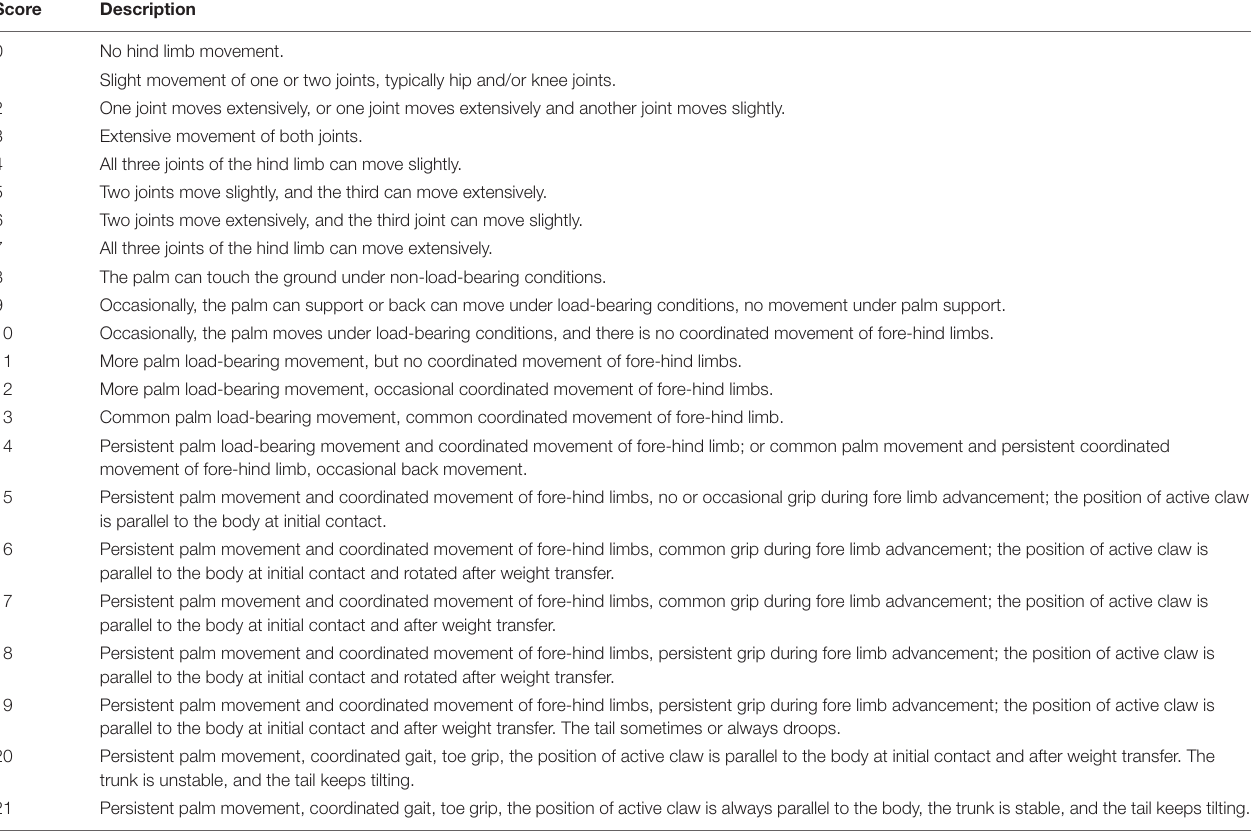
TABLE 1 | BBB score.